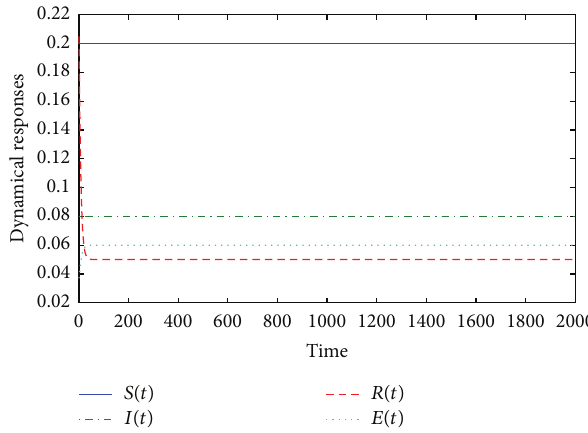
Figure 1: Dynamical responses of model system (123) with state feedback controller, which shows that model system (123) is stable around (0.2,0.08, 0.05, 0.06)